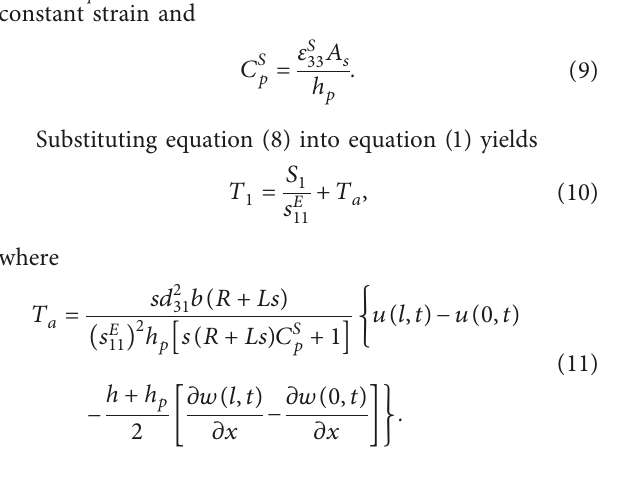
Figure 2: Sketch of the unit . ( 3 )